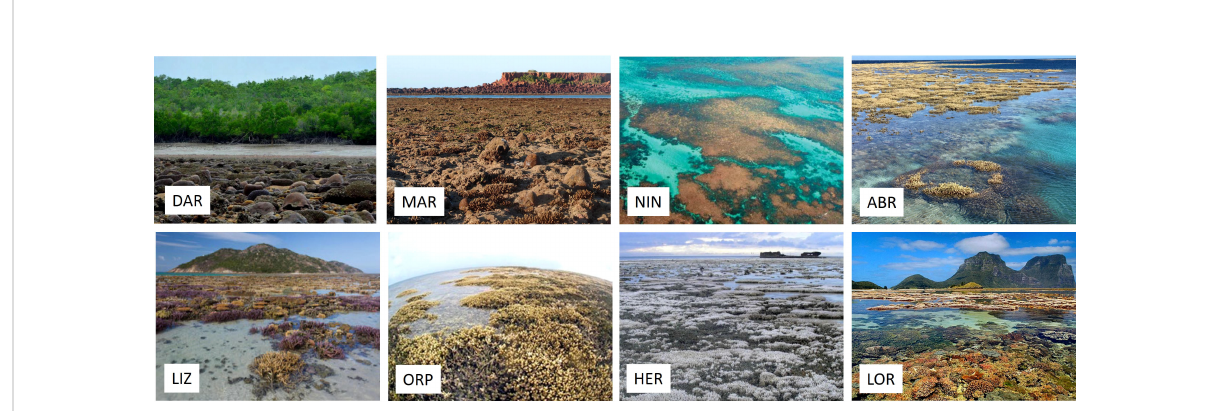
FIGURE 2 Photos depicting recorded emersion events for each study site. Photographs reproduced with permission from the following individuals and organizations: DAR (photo credit Craig Blount, © INPEX), MAR (photo credit Zoe Richards), NIN (from Armstrong et al., 2007, © Department of Biodiversity Conservation and Attractions), ABR (photo credit Jo Buckee), LIZ (photo credit Michael Bok), ORP ( © Centre for Excellence in Coral Reef Studies), HER (photo credit Andrew Thurber), LOR (Image Courtesy Black Diamond